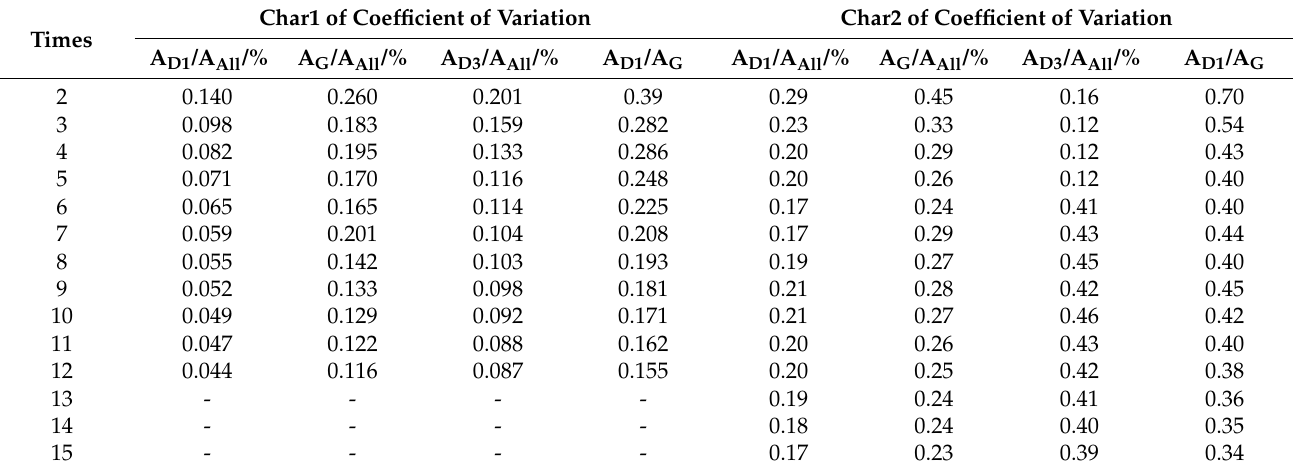
Figure 8. Standard deviations and corresponding derivatives of char2 Raman characteristic parameters. Table 6. Variation coefficients of Raman parameters for char1 and char2 for different detection